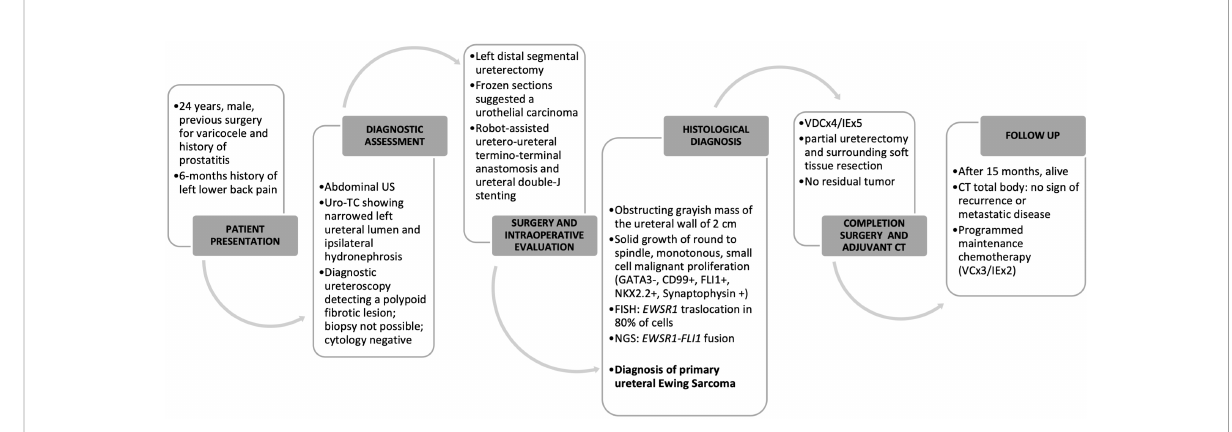
FIGURE 4 Temporal